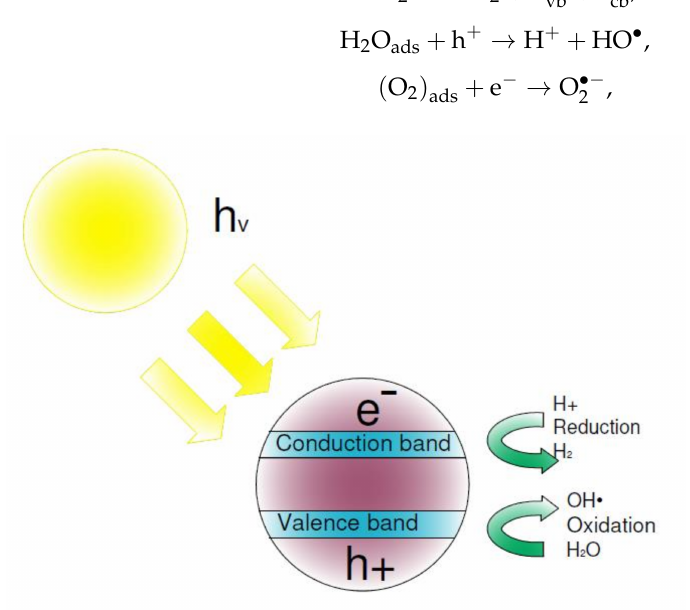
Figure 1. A schematic mechanism of the photocatalytic